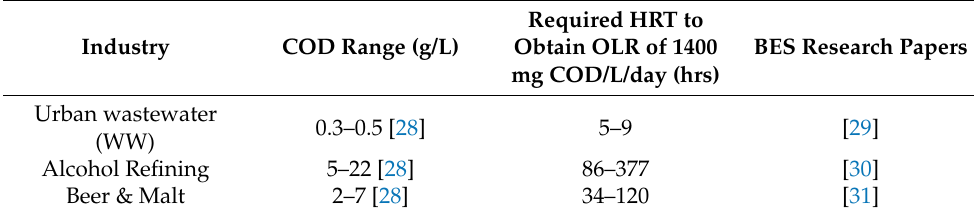
Table 1. Industrial Wastewater COD Range adapted from [28] with the required hydraulic